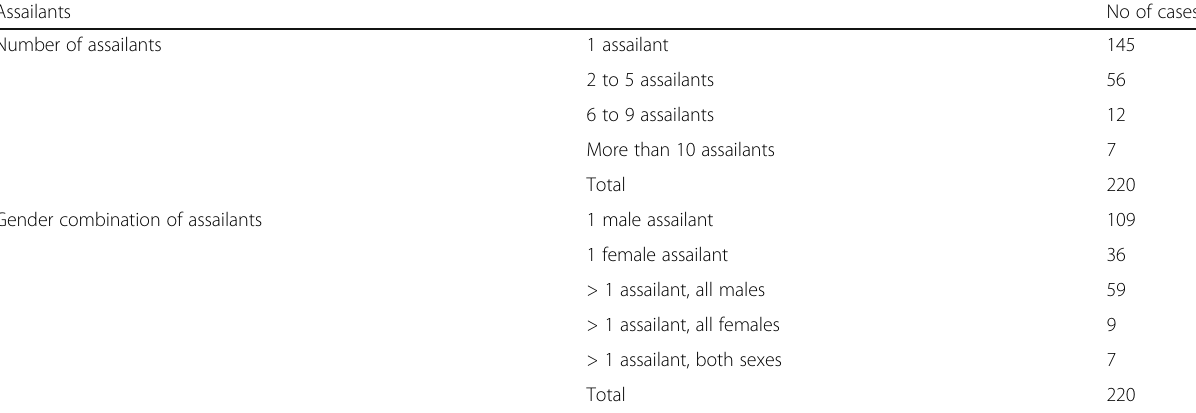
Table 2 The numbers and gender of the assailants in the studied cases of non-fatal interpersonal violence Assailants